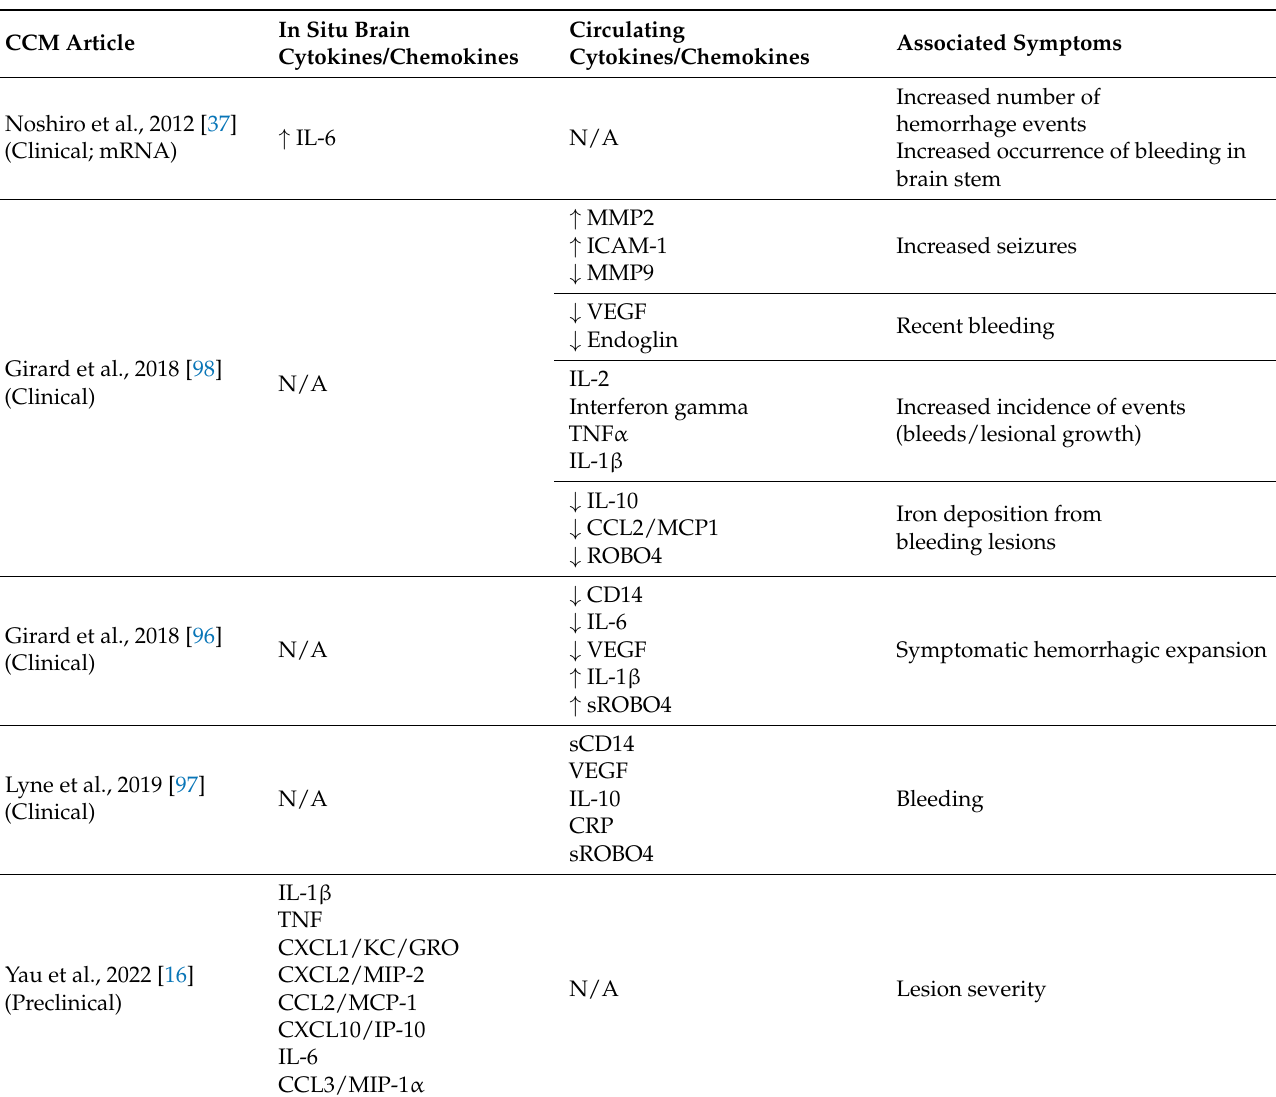
Table 3. Cytokine and chemokines in CCM associated with lesion severity and